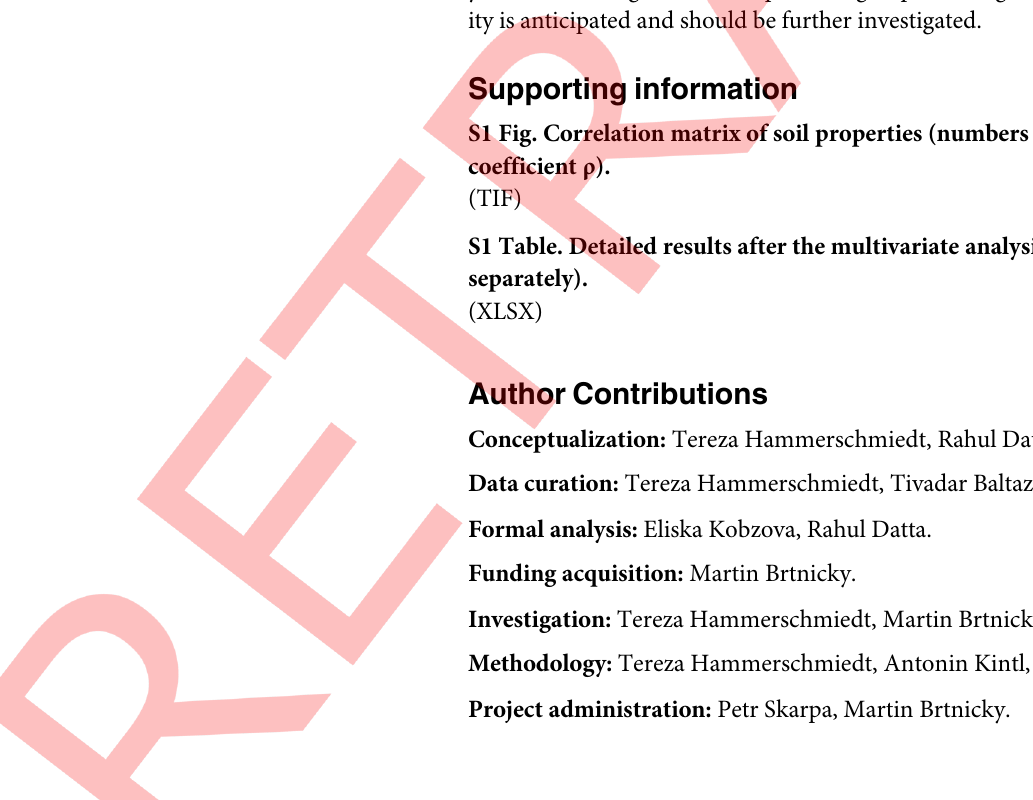
S1 Fig. Correlation matrix of soil properties (numbers indicate the Pearson’s correlation coefficient ρ ). S1 Table. Detailed results after the multivariate analysis of variance MANOVA (ANOVA